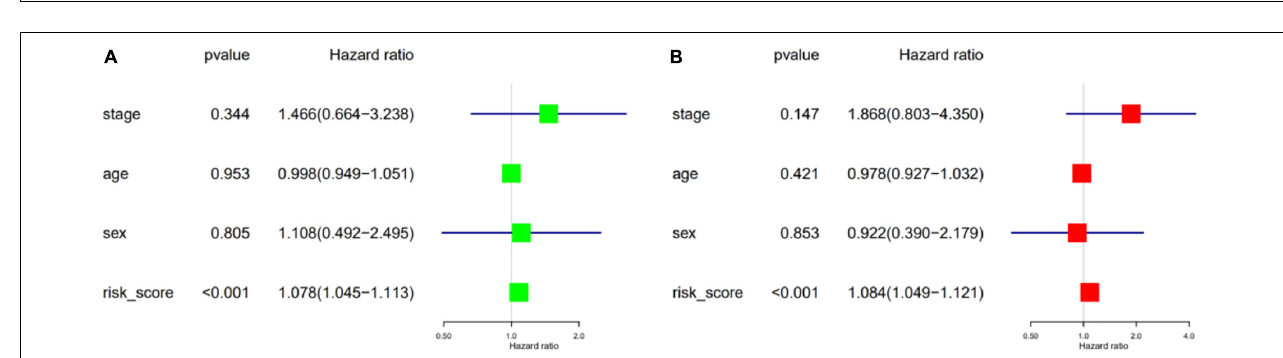
FIGURE 8 | Validation of independent prognostic factors. The univariate (A) and multivariate (B) Cox regression analysis of risk score, age, gender, and